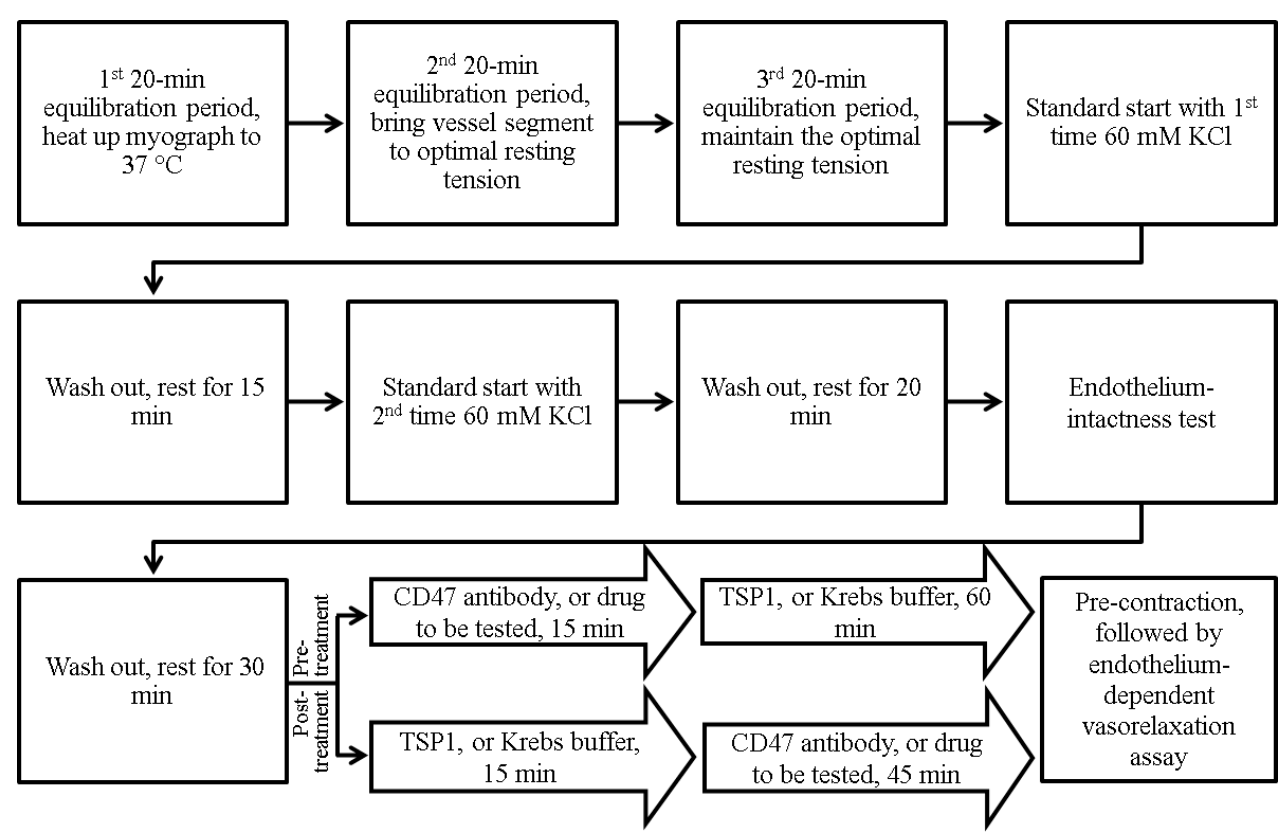
Figure 1. A complete process flow diagram of the experimental setup. ( A ) Workflow starting from tissue harvest until mounting of isolated vascular tissues onto myograph. ( B ) Experimental setup procedure for screening of proposed drug candidates using an ex vivo model, along with appropriate controls.